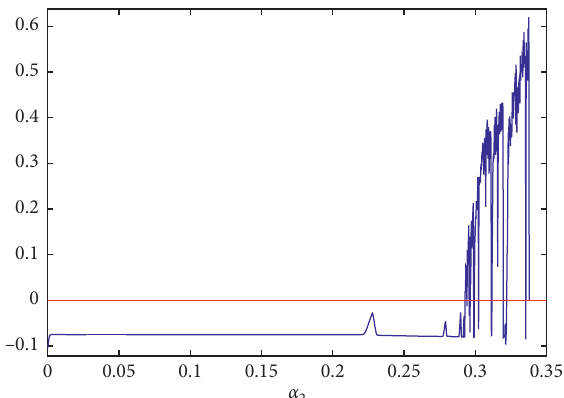
Figure 4: Maximal Lyapunov exponent for α